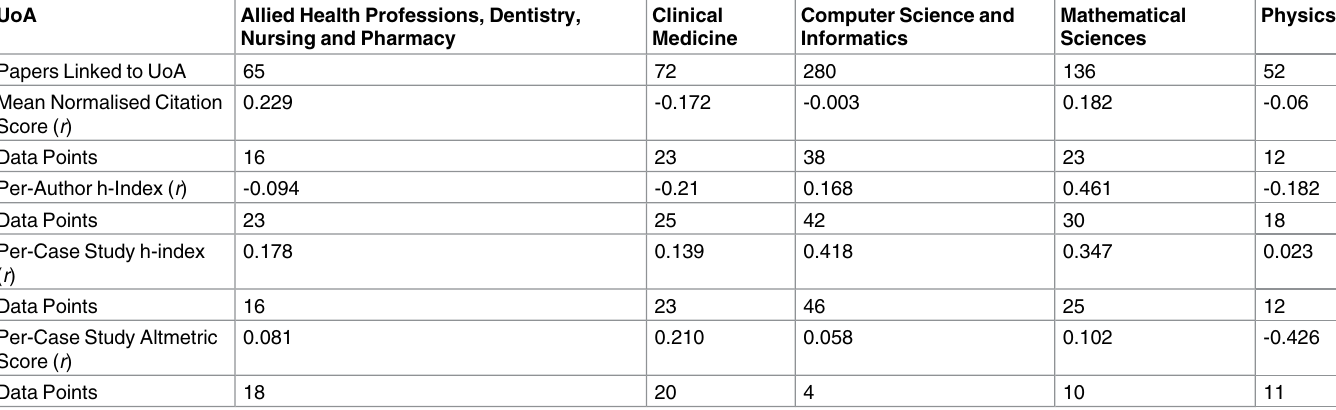
Table 3. Pearson r coefficient scores for metricsevaluated against REF Impact